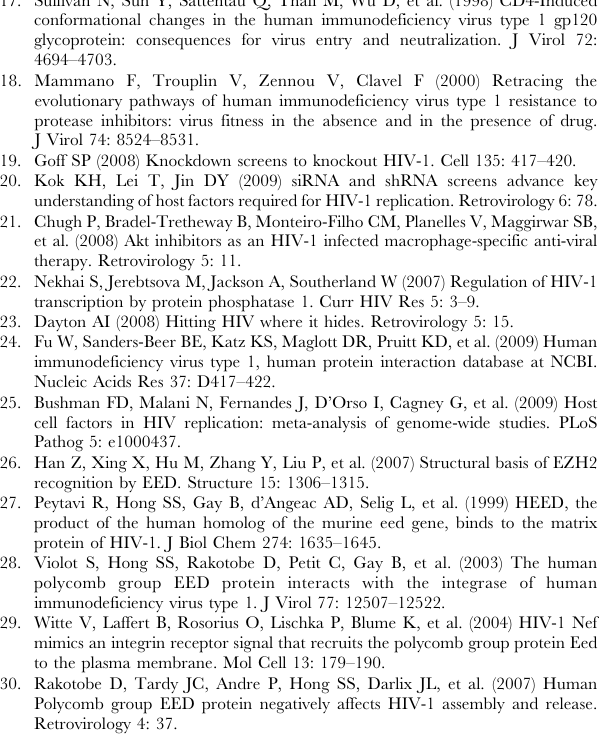
Table S3 Genes identified in this screen important for HIV-1 replication. Gene information is described, in particular subcellu- lar localization, molecular class and cellular function.